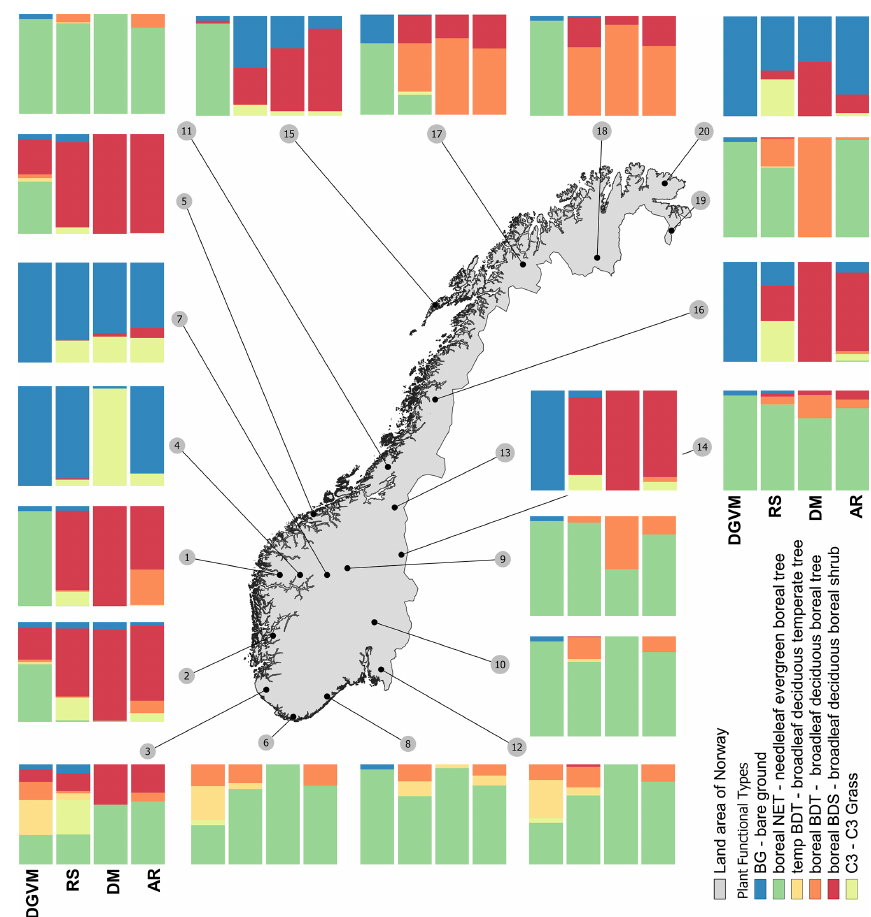
Figure 3. PFT profiles for each of the 20 plots for the three methods compared in this study and the AR reference dataset. The columns in each cluster of the four bar charts represent, from left to right, the methods of the dynamic global vegetation model (DGVM), remote sensing (RS) and distribution model (DM), with the AR reference dataset to the